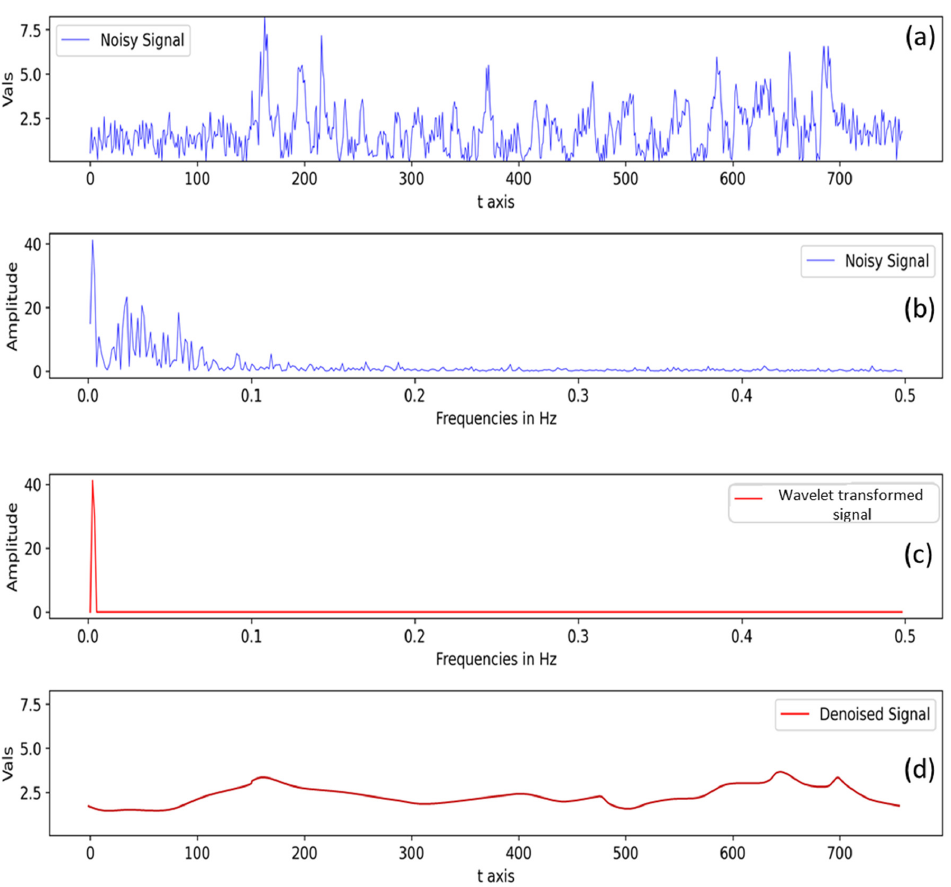
Figure 11. Processed signal after non-vegetative signal compensation ( a ) signal in time domain and ( b ) signal in frequency domain. Signal denoising with wavelet-transformation-denoised ( c ) signal in frequency domain, and ( d ) denoised signal in time domain.